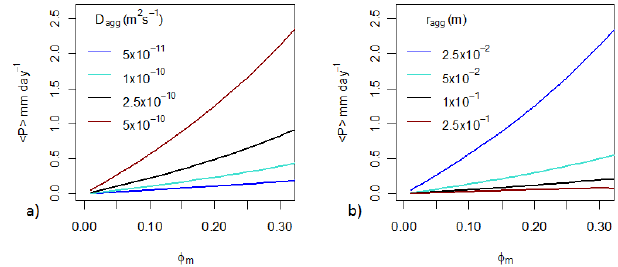
D agg for a given aggregate radius ( r agg ) of 10 − 2 m (a) and with